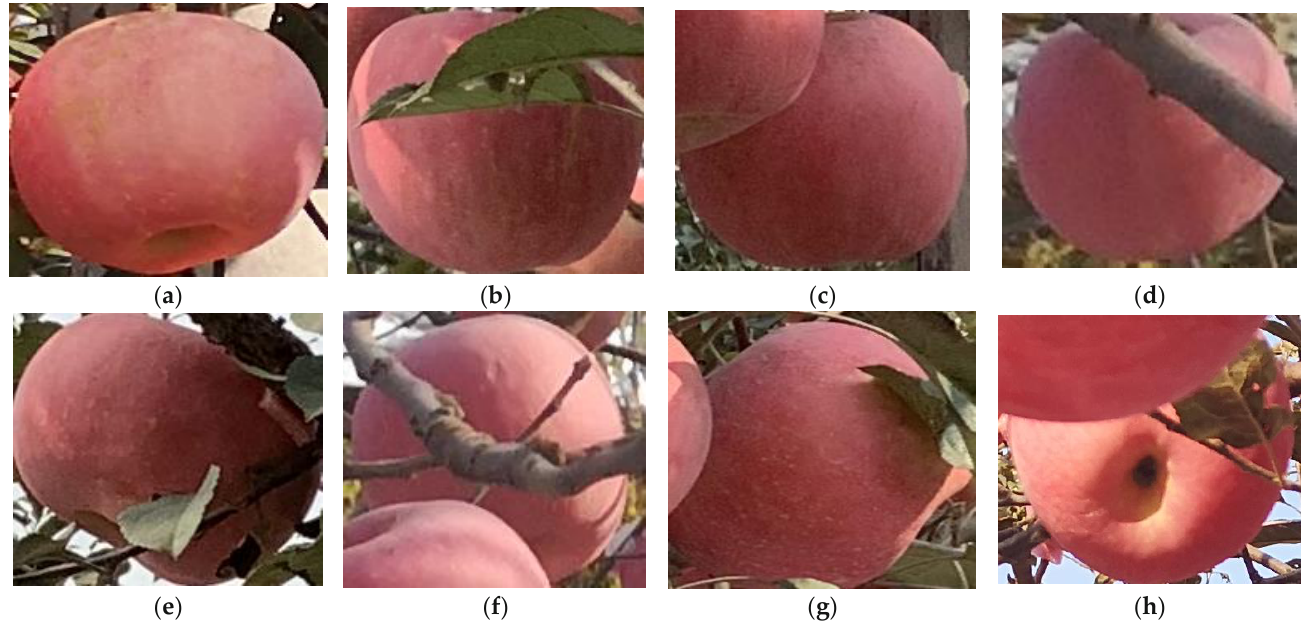
Figure 2. Annotation classes: ( a ) no occlusion; ( b ) leaf occlusion apples; ( c ) fruit occlusion; ( d ) branch occlusion; ( e ) leaf and fruit occlusion; ( f ) leaf and branch occlusion; ( g ) branch and fruit occlusion; and ( h ) leaf, branch, and fruit occlusion.